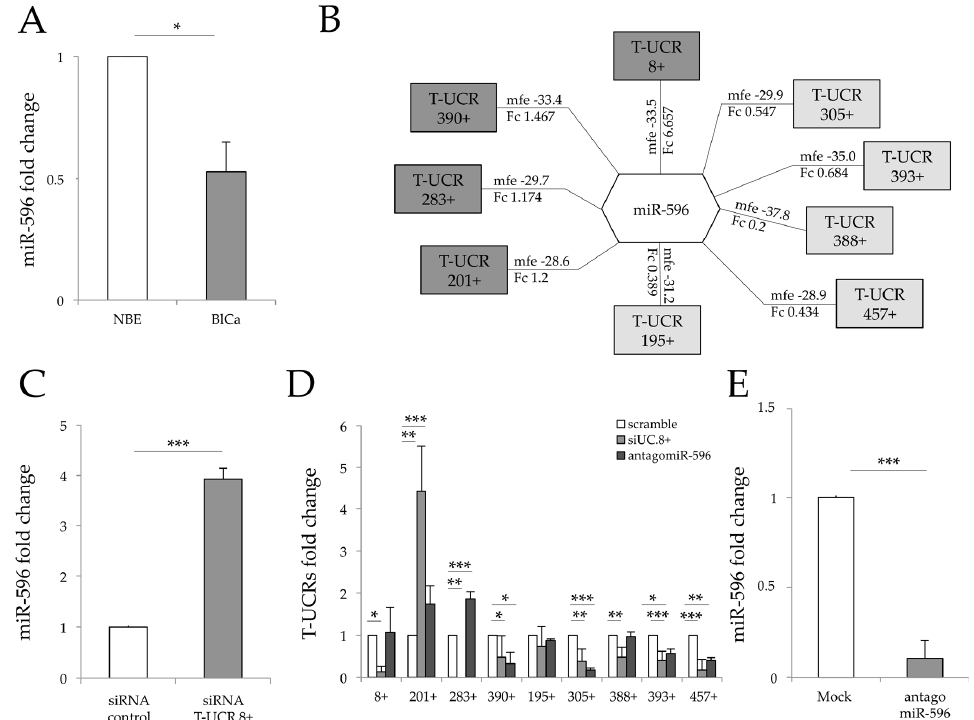
Figure 1. Transcribed ultraconserved regions (T-UCRs)::miR-596 interaction network and long non-coding RNA (lncRNA) expression levels following T-UCR 8+ and miR-596 downregulation. ( A ) miR-596 fold change comparison between bladder cancer (BlCa) and normal bladder epithelium (NBE) samples. We compared miR-596 expression in 24 BlCa patient samples and 17 NBE samples (clinical characteristics shown in Table S4); ( B ) Schematic representation of T-UCRs::miRNA-596 possible network. For each T-UCR, the minimum free energy (mfe) involved in miRNA-596 binding and the fold change (Fc) in BlCa samples compared to NBE are reported. Upregulated and downregulated T-UCRs in J82 bladder cancer cell lines are shown in dark grey and light grey respectively; ( C ) miR-596 expression change in T-UCR 8+-silenced cells vs scramble oligo-transfected cells; ( D ) Real-time quantification of the selected T-UCRs in T-UCR 8+ J82-silenced cells and in antagomiR-596 and scramble oligo-transfected cells; ( E ) Real-time dosage of miR-596 in antagomiR-596-transfected cells. Data are reported as fold change considering scrambles equal to 1 and as mean ± standard deviation (SD) of triplicate values. p values were obtained using the Student t -test for three independent samples. * p < 0.05, ** p < 0.01, *** p < 0.001 vs controls.